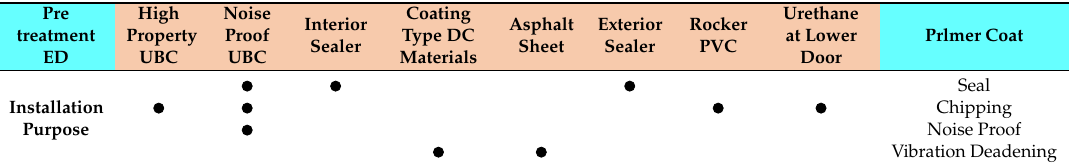
Table 1. Purposes and types of sealants used in automobiles.